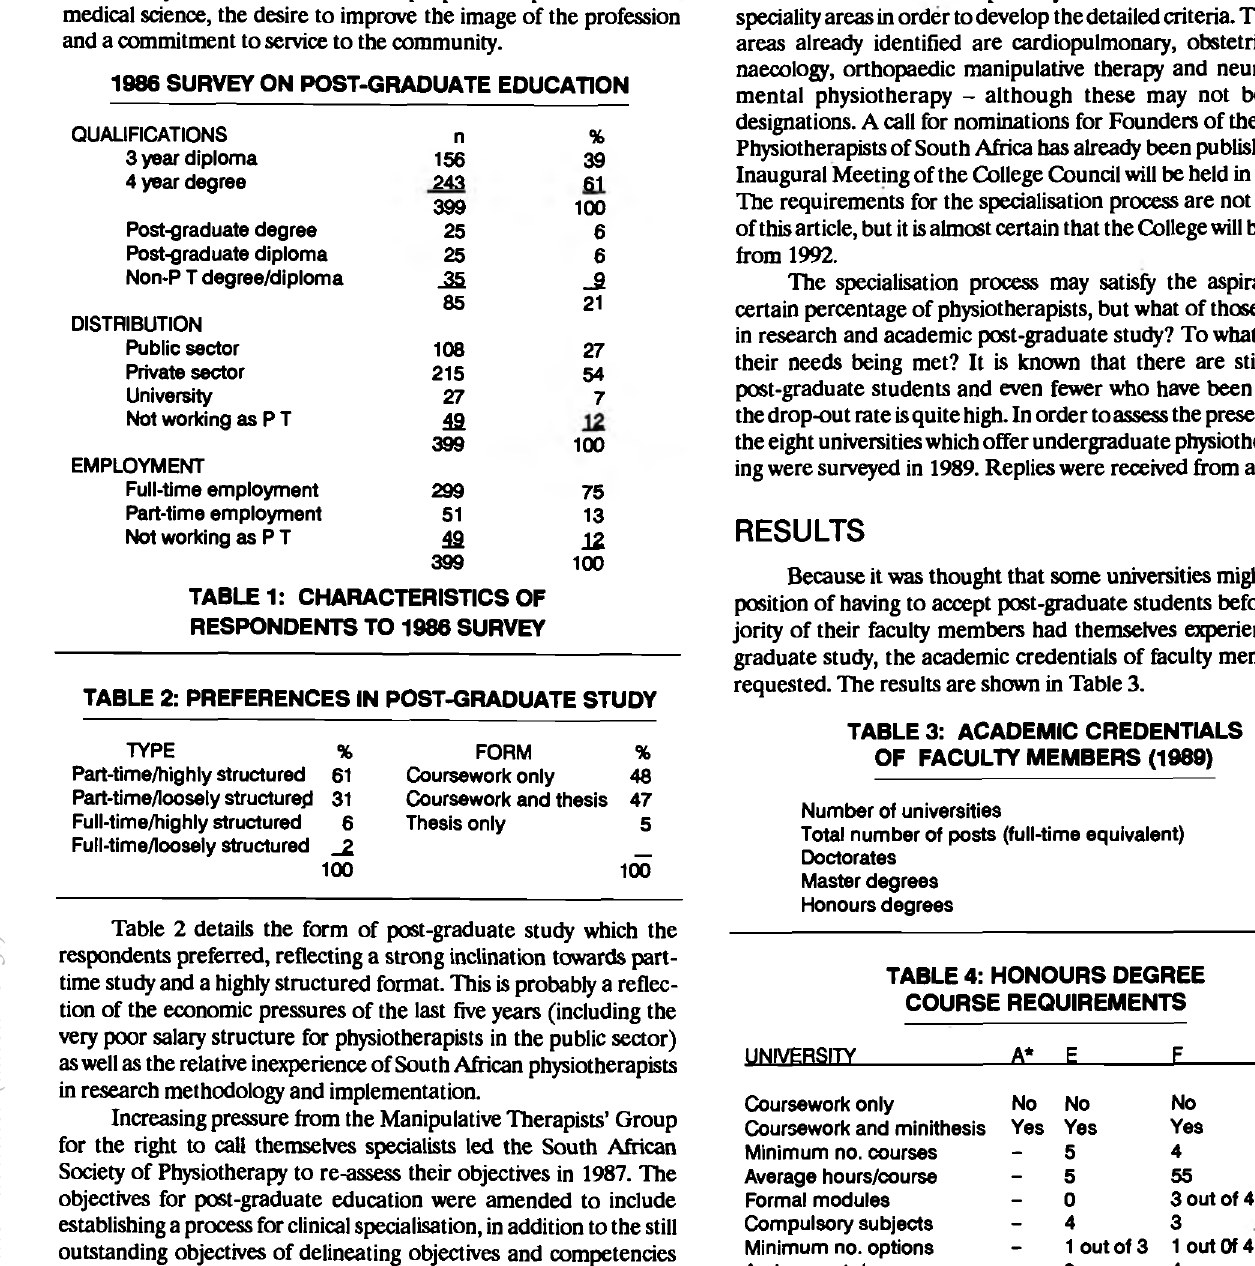
TABLE 2: PREFERENCES IN POST-GRADUATE STUDY